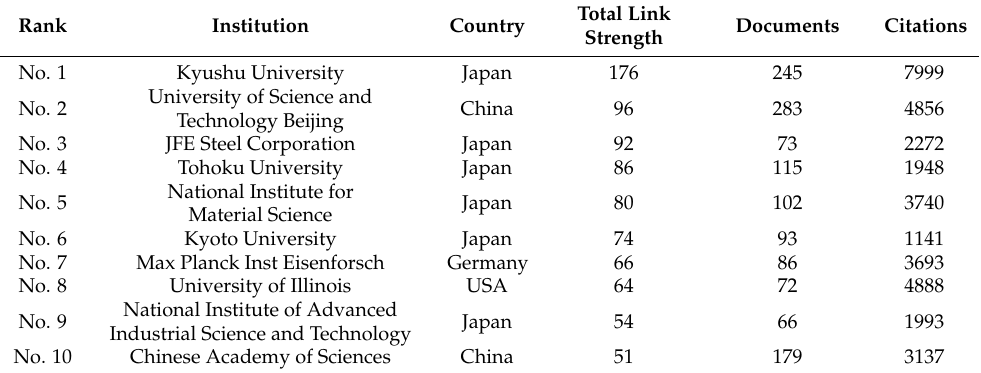
Table 3. Top ten institutions with the highest total link strengths for hydrogen embrittlement research.